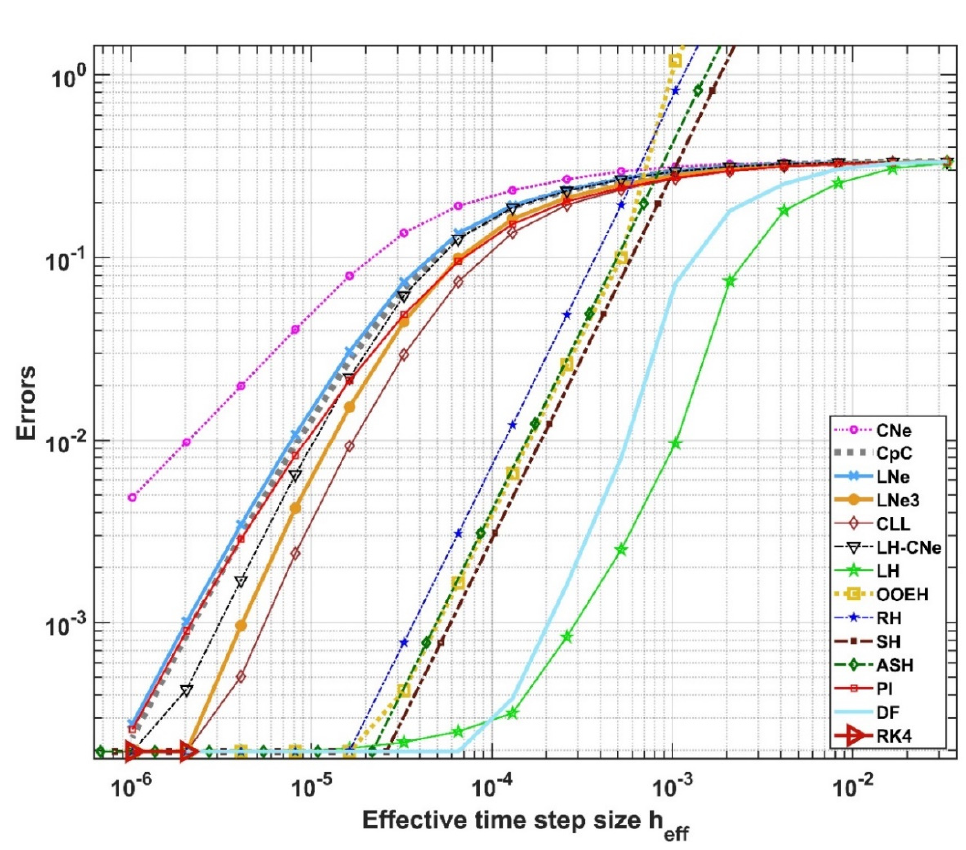
Figure 12. The L ∞ errors as a function of the time step size h for a decreasing mesh (Experiment 4).